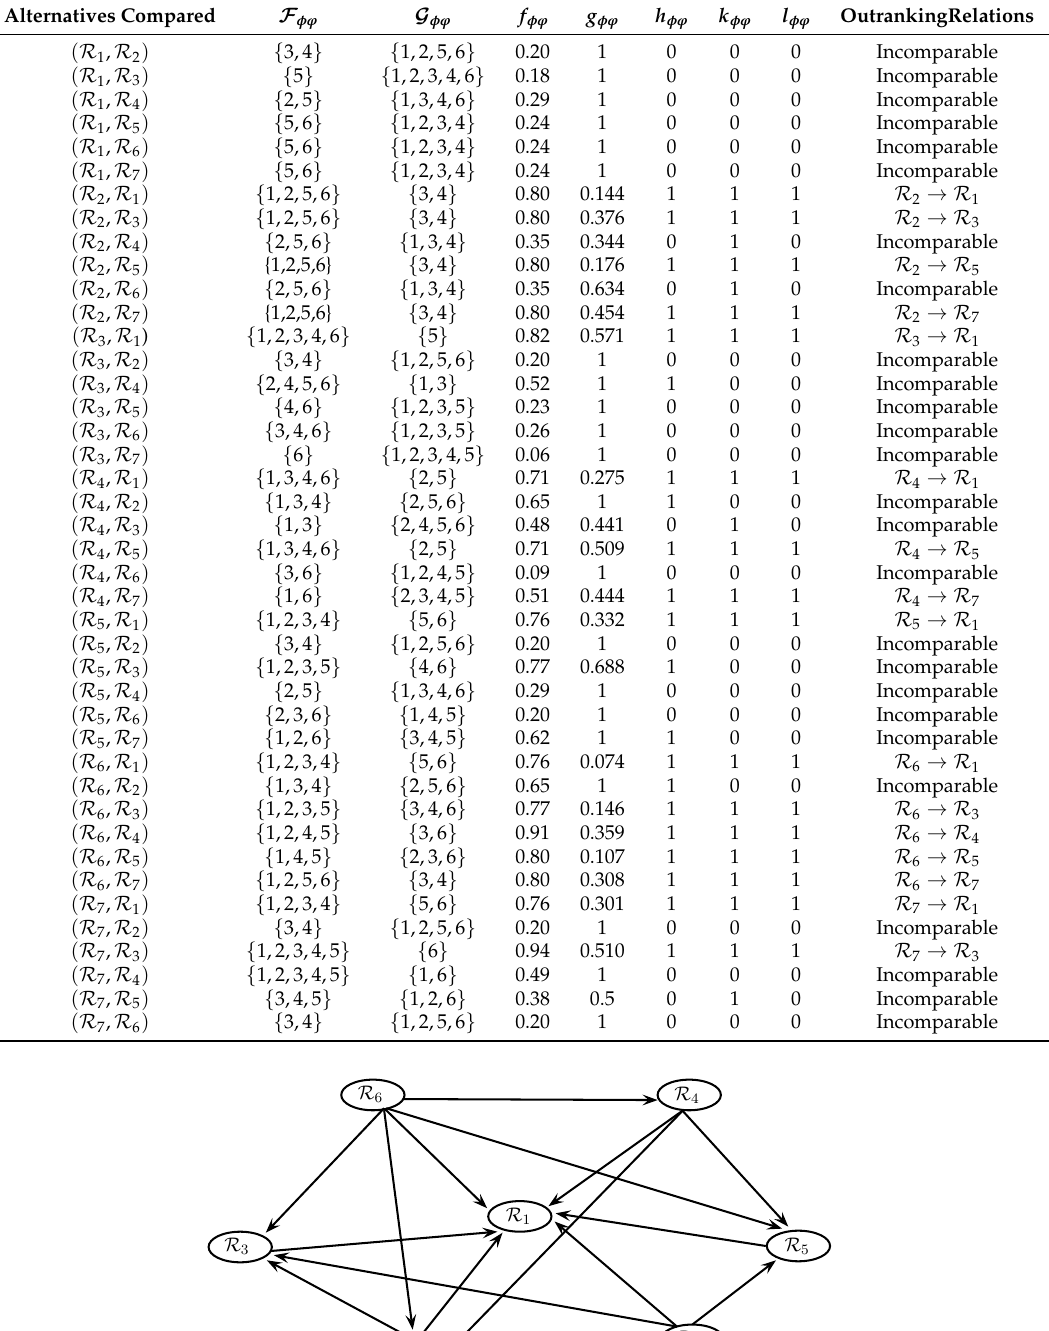
Table 19. m F ELECTRE I results for selection of hydroelectric power plant.